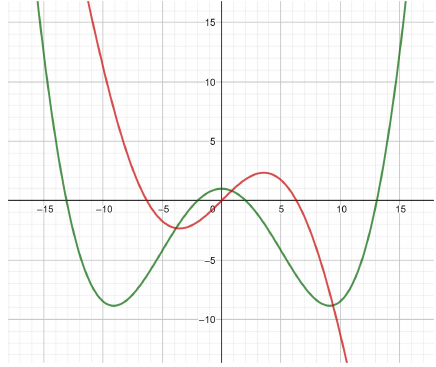
Figure 2. cos 1 ( x ) , (green) and sin 1 ( x ) , (red).